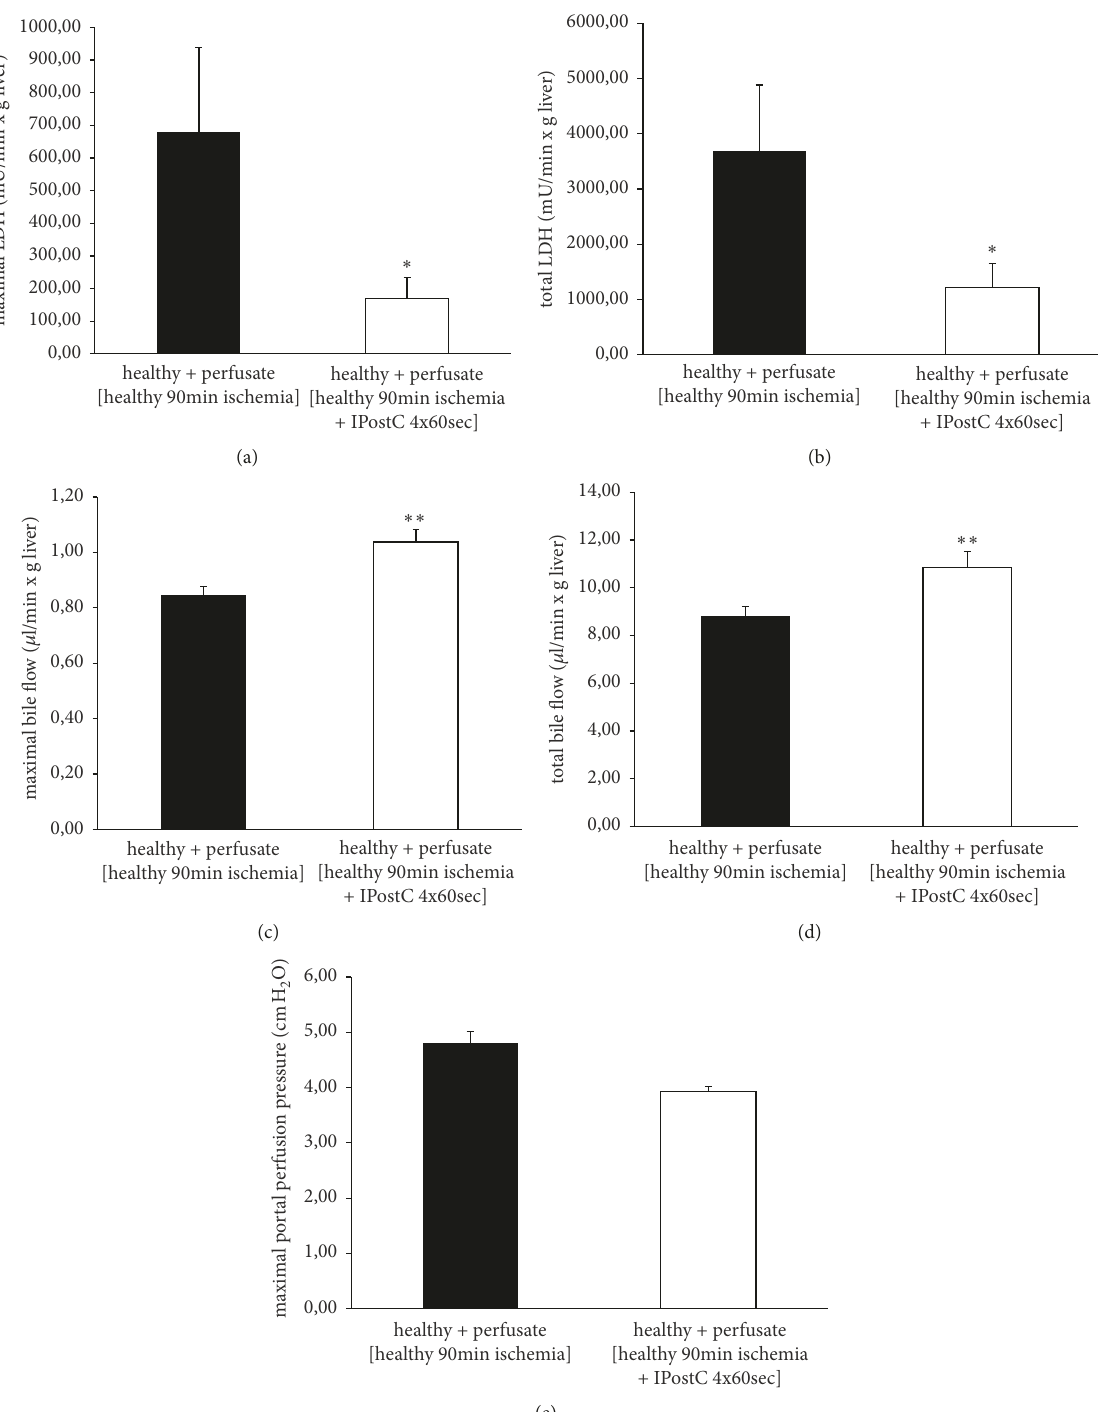
Figure 5: Lactate dehydrogenase, bile flow, and portal perfusion pressure in healthy livers after follow-up study ± IPostC . Warm ischemia in situ ± IPostC 4x60 sec was performed in the healthy livers of male SD rats. The perfusate of reperfusion was collected and subsequently used to perfuse additional healthy livers (postconditioned and nonpostconditioned, each with n=6). Lactate dehydrogenase (LDH) was measured in the perfusate and bile was collected during the time of perfusion. Both LDH and bile flow are shown as maximal (LDH (a); bile (c)) and total (LDH (b); bile (d)) values. The portal perfusion pressure (e) was monitored continuously and is represented as maximal value. Data are expressed as the mean ± SEM. Significant values are specified as ∗ p < 0.05 and ∗∗ p <